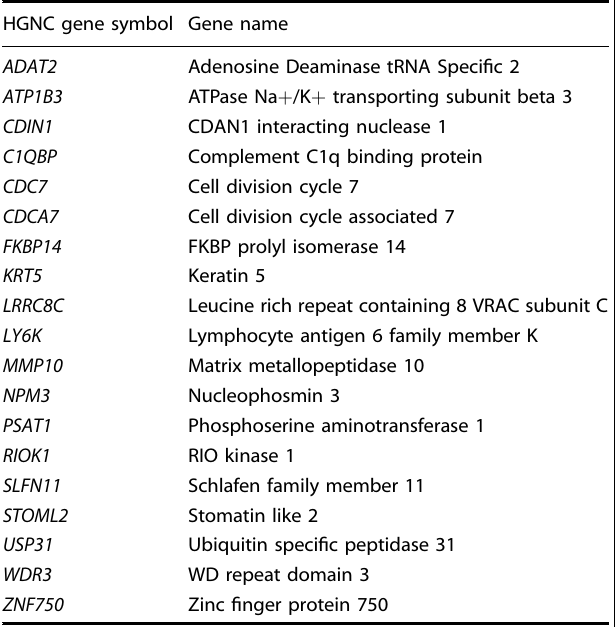
Table 1. Genes included in